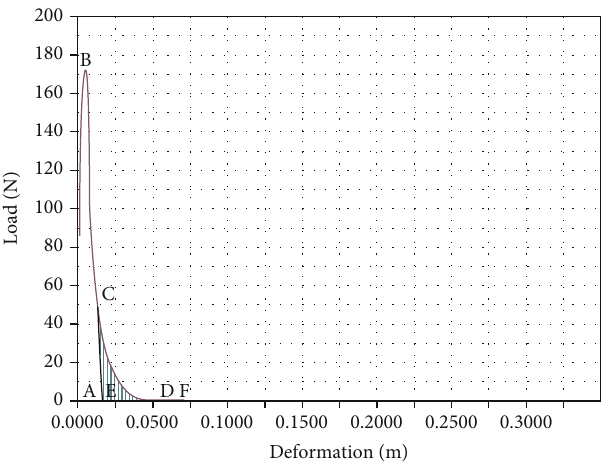
Figure 6: 4# tire rubber powder-modi fi ed asphalt viscosity test load-deformation diagram.